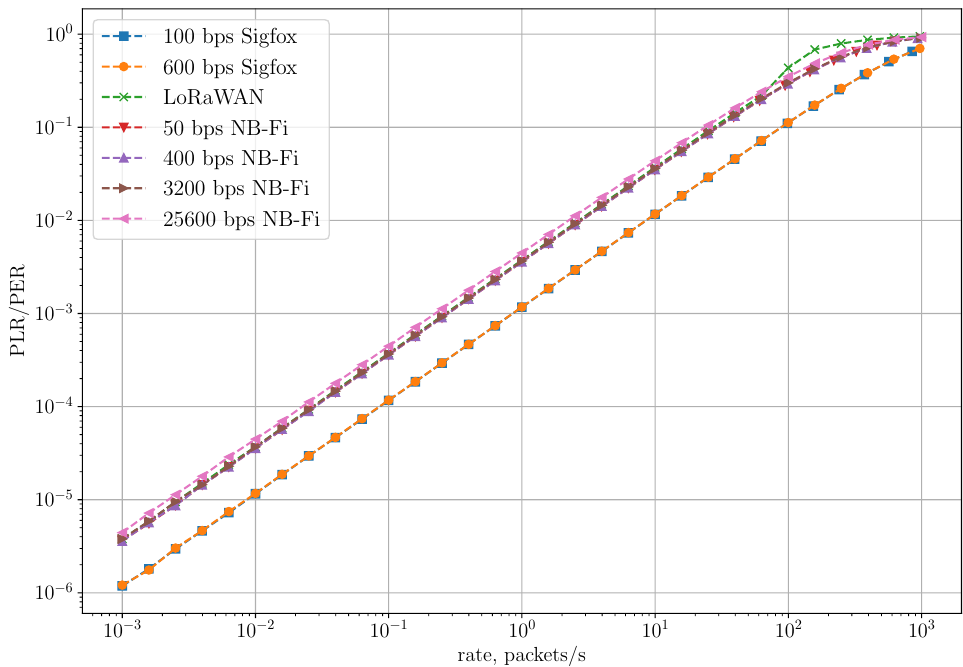
Figure 10. PLR and PER in the unreliable transmission of short packets scenario.